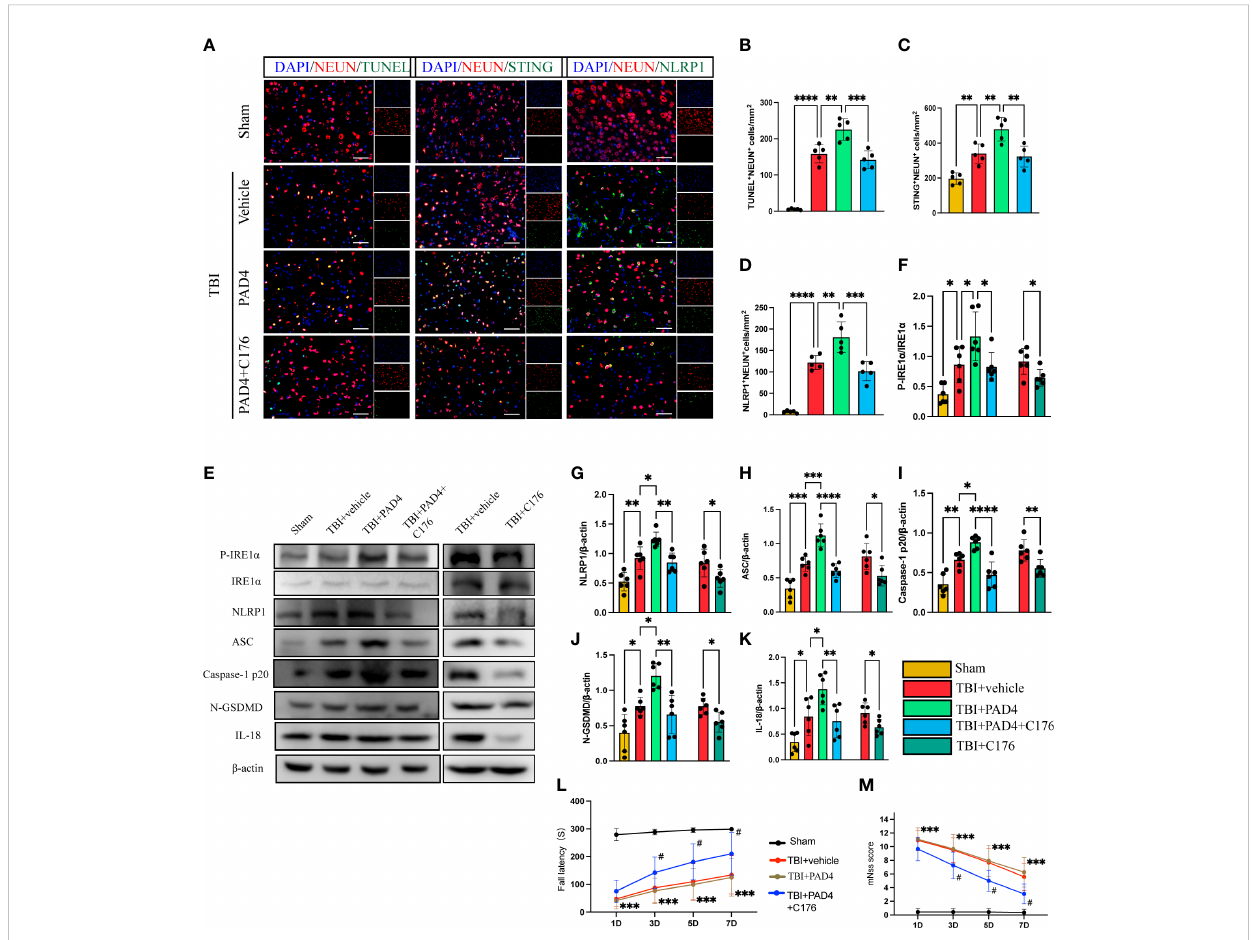
FIGURE 6 Overexpression of PAD4 exacerbates neurons ’ pyroptosis by promoting the STING-IRE1 a -NLRP1 pathway. (A) Representative fl uorescent double stain images of NEUN-positive neurons with TUNEL-positive cells (green), STING-positive cells (green) and NLRP1-positive cells (green) in the peritraumatic cortex(n=5). Nuclei were stained with DAPI (blue). Scale bar = 50 m m. Count and analyze the number of double-stained positive cells of NEUN-positive neurons with TUNEL-positive cells (B) , STING-positive cells (C) and NLRP1-positive cells (D) . (E) Representative Western blot bands of P-IRE1 a , NLRP1, ASC, Caspase-1 p20, N-GSDMD, IL-18 and statistical analysis expression level of P-IRE1 a (F) , NLRP1 (G) , ASC (H) , Caspase-1 p20 (I) , N-GSDMD (J) and IL-18 (K) in brain tissue of mice post-TBI 3 days (n=6). Rotary test (L) and mNSS (M) were used to evaluate the neural function of mice treated with PBS and Anti-Ly6G compared with the Sham group at 1 d, 3 d, 5 d, 7d after TBI (n = 12). Data are presented as mean ± SD. *P < 0.05, **P < 0.01, ***P < 0.001 and ****P < 0.0001 compared within two groups. # p < 0.05 and vs PAD4+C176